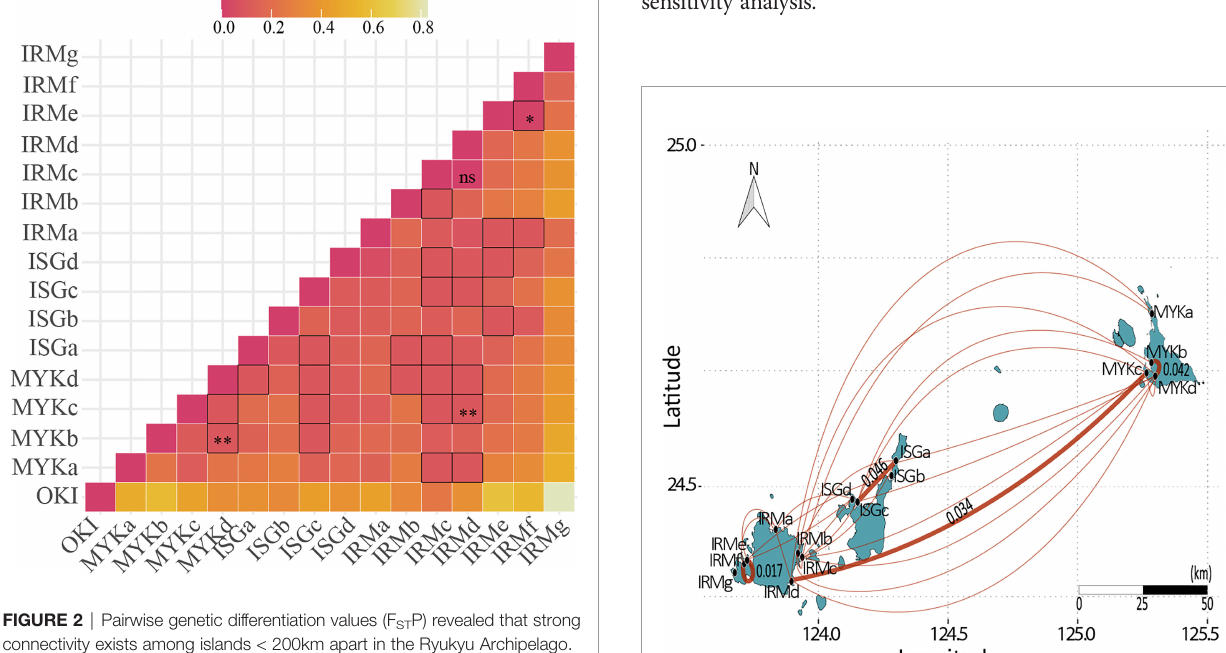
axes show site names, and the fi gure shows no directionality. P-values < 0.01 for all pairs, except for grids with *, ** and NS indicating p > 0.1, 0.05 < p < 0.1, and not-signi fi cant, respectively.